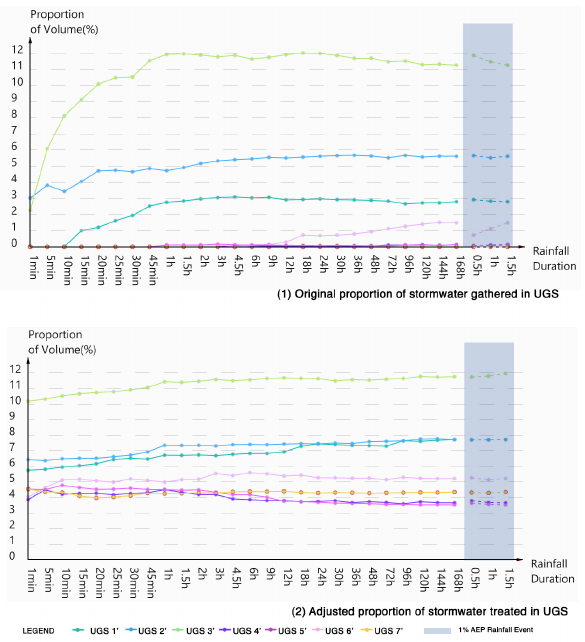
Figure 8. Rainfall Events Testing Result For Test Site 2